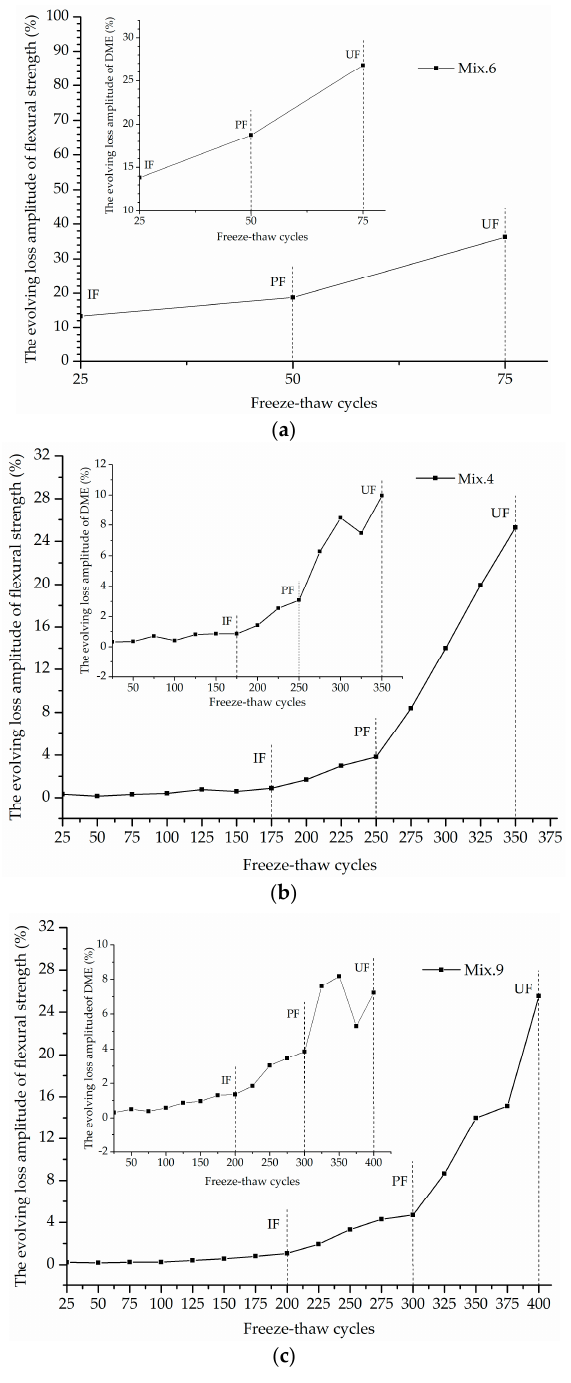
Figure 9. The evolving loss amplitude of engineering property for typical ECC mixtures: ( a ) Mix. 6; ( b ) Mix. 4; ( c ) Mix. 9.